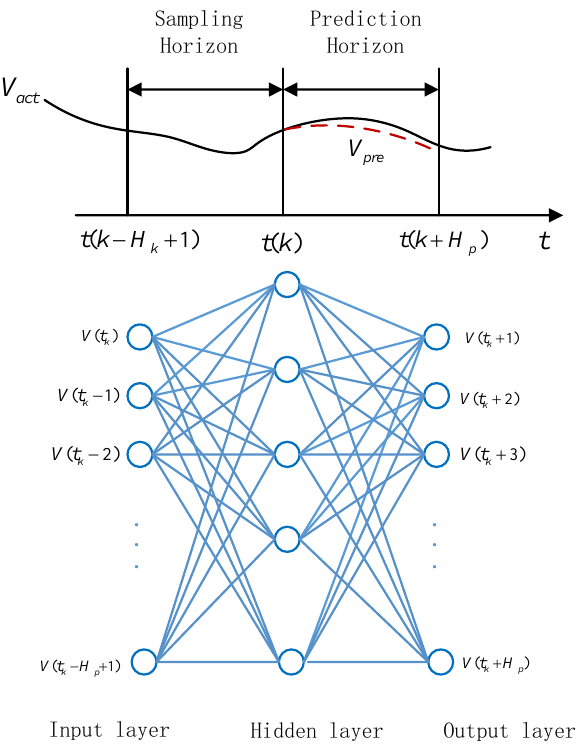
Figure 6. Schematic diagram of velocity predictor based on GRU.